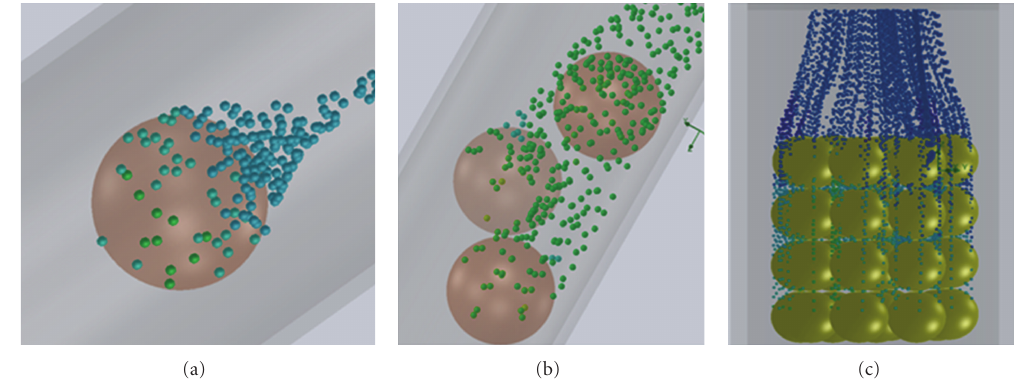
Figure 16: Desorption of water vapour in porous materials.